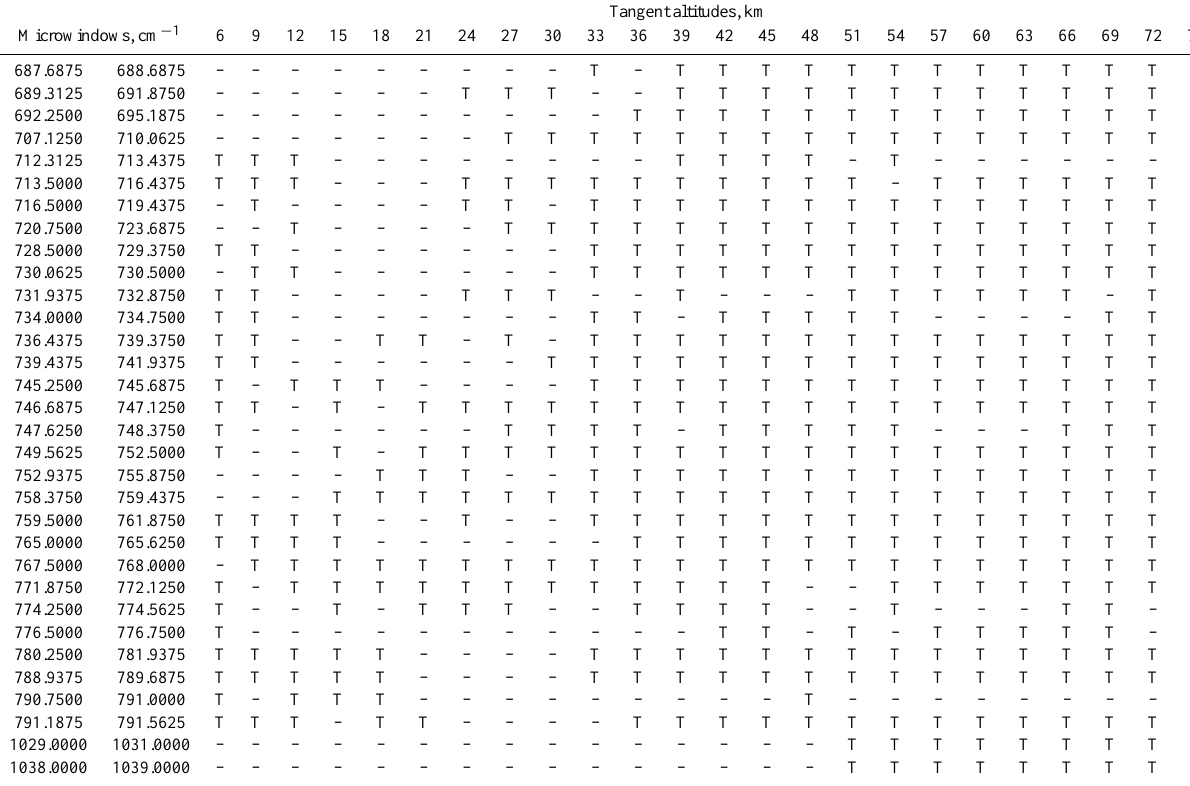
Tangent altitudes, km